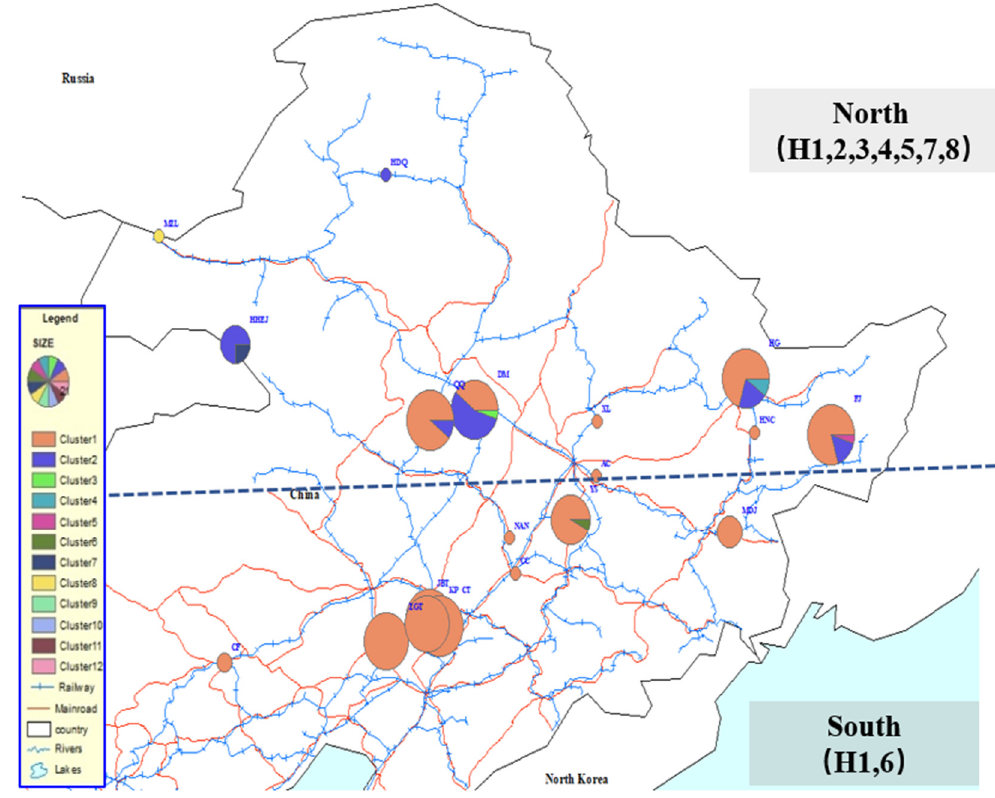
Figure 6. Chinese S. noctilio populations grouped by latitude (north to south) and their haplotype projections.